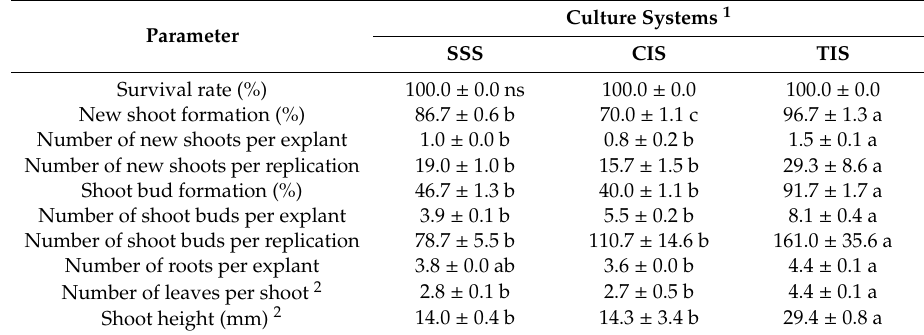
Figure 1. Growth and development of Epipactis flava plantlets at four weeks after culture in semi-solid system ( SSS ), continuous immersion system ( CIS ) and temporary immersion system ( TIS ). Table 1. E ff ect of culture systems on growth and development of Epipactis flava plantlets for four weeks of